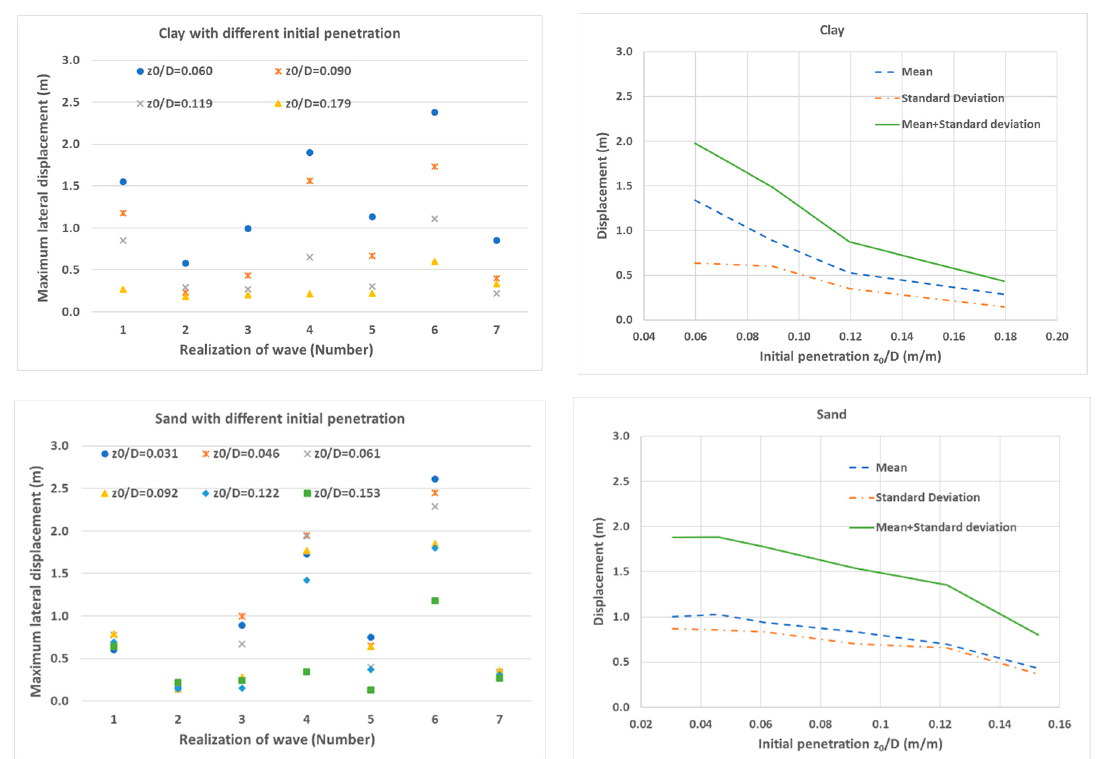
Figure 7. The lateral displacement of the umbilical for seven wave realizations and the mean and standard deviation of lateral displacement (with different initial penetration).